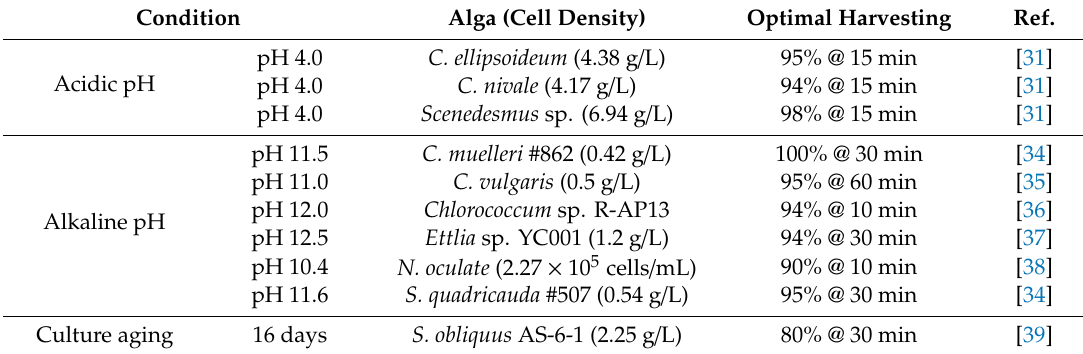
Table 1. Comparison of auto-flocculation techniques for algae